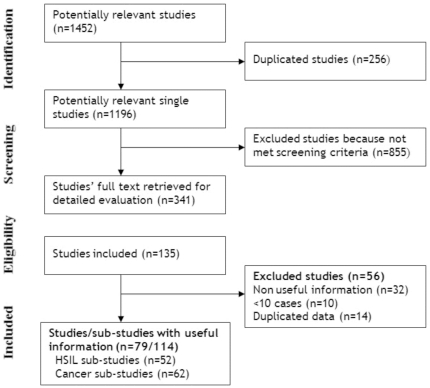
Study flow diagram.